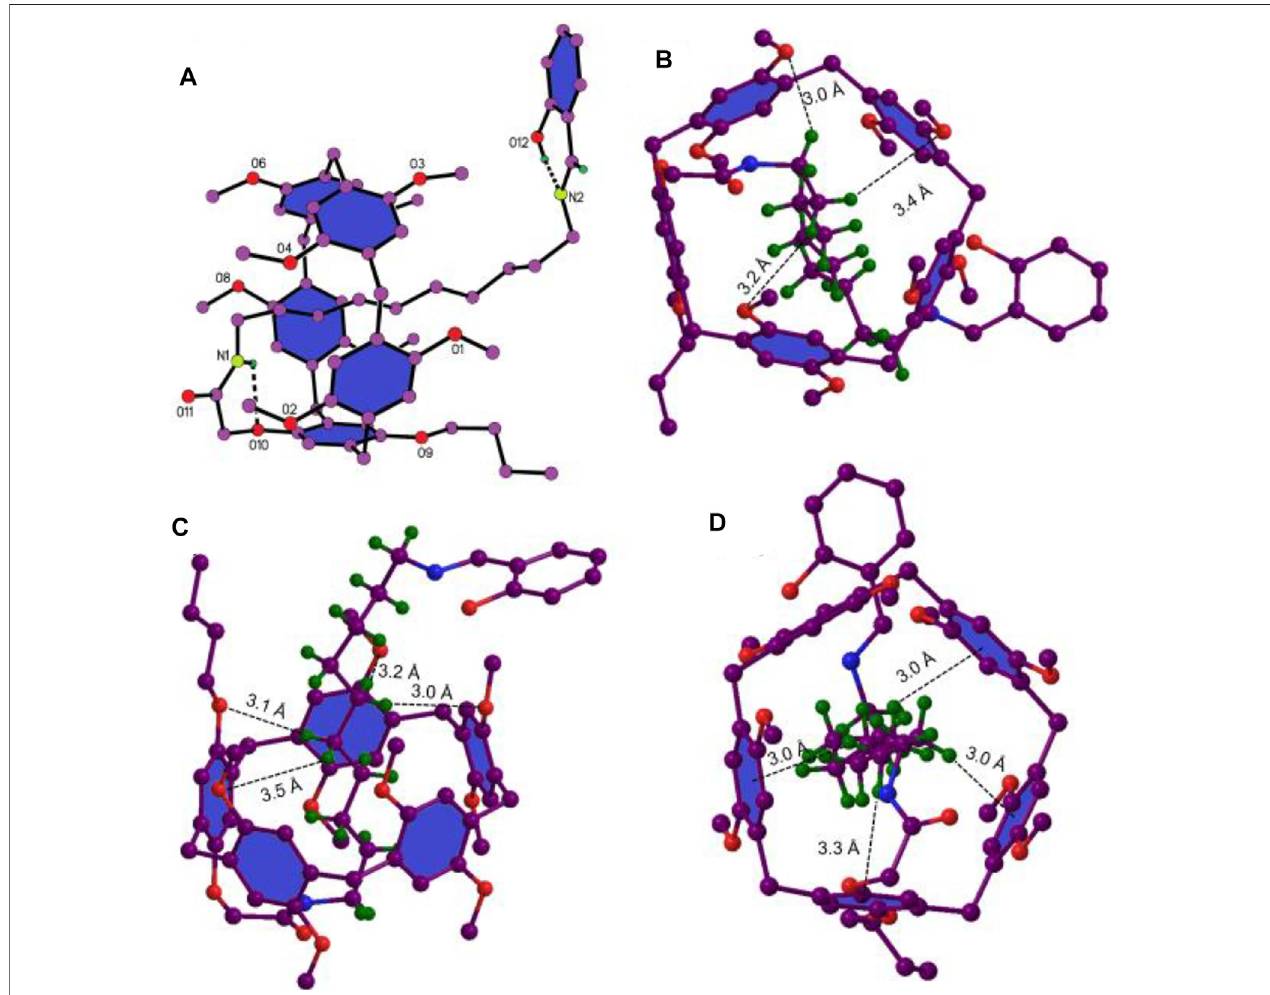
FIGURE 3 | The single-crystal structure of 6e , where only the hydrogens in question are given for clarity. (A) N – H ··· O and O – H ··· N hydrogen bonding. (B) and (C) C – H ··· O interaction, H ··· O distances, 3.0 Å, 3.2 Å, 3.4 Å, 3.0 Å, 3.2 Å, 3.1 Å, and 3.5 Å. (D) C – H ··· π interactions, H ··· ring center distances, 3.0 Å, 3.3 Å 3.0 Å, and 3.0 Å.